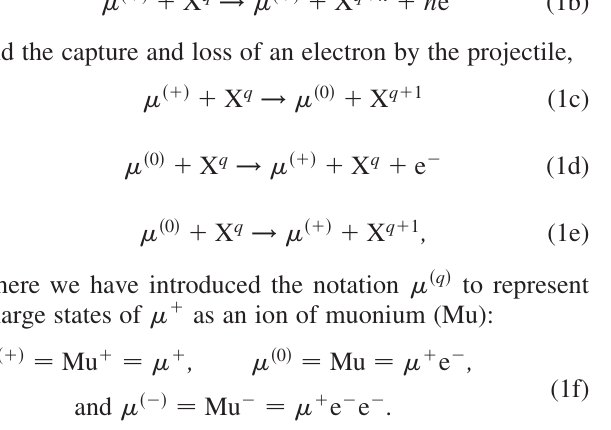
TABLE I. Energy spreads of frictionally cooled beams of (cid:1) (cid:1) in H gas from [4] and (cid:1) þ in He; and gradient of the stopping 2 for (cid:1) (cid:1) from the parametrization in [14]. power of H 2 T [keV] eq dS=dT [ cm 2 = mg ]